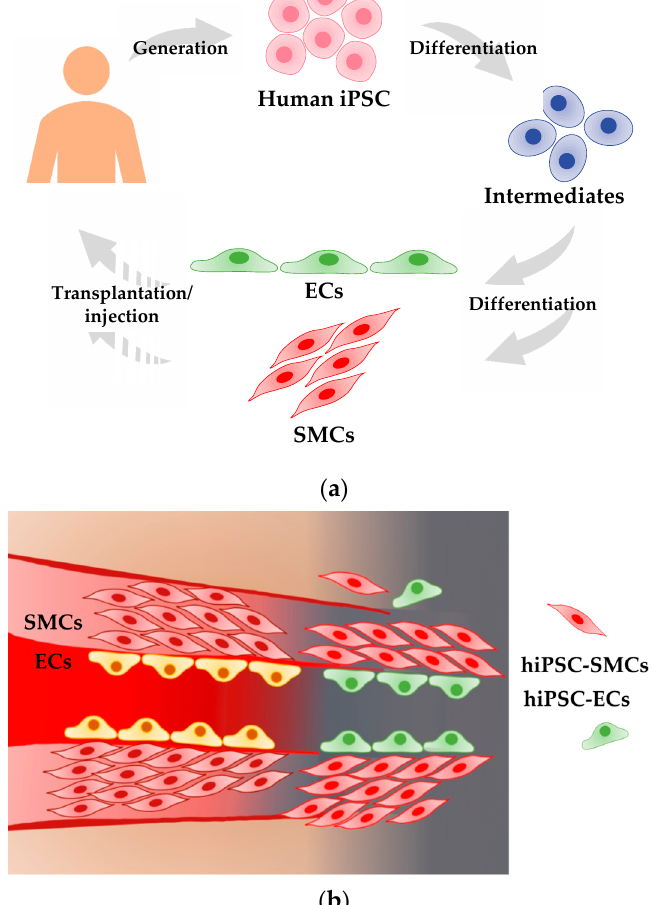
Figure 1. Proposed scheme for clinical application of hiPSC-derived vascular cells to treat patients with ischemic cardiovascular diseases. ( a ) Human iPSCs can be generated from somatic cells, such as skin fibroblasts and blood cells. Human iPSCs can differentiate into either ECs or SMCs via intermediates. The resulting vascular cells can be used for cell-based therapy to induce neovascularization. Solid arrows indicate verified and validated steps. Dashed arrows indicate speculative steps yet to be demonstrated. ( b ) Transplanted hiPSC-derived ECs incorporate into vessels, which are covered by hiPSC-derived SMCs, to form neovascularization in ischemic regions.